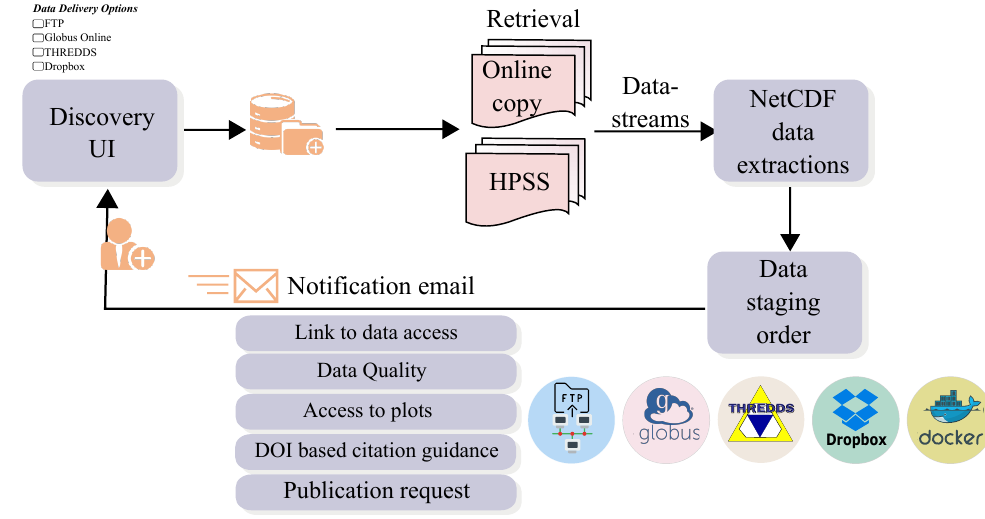
Figure 9. ARM workflow: data retrieval, packaging, and delivery (source: